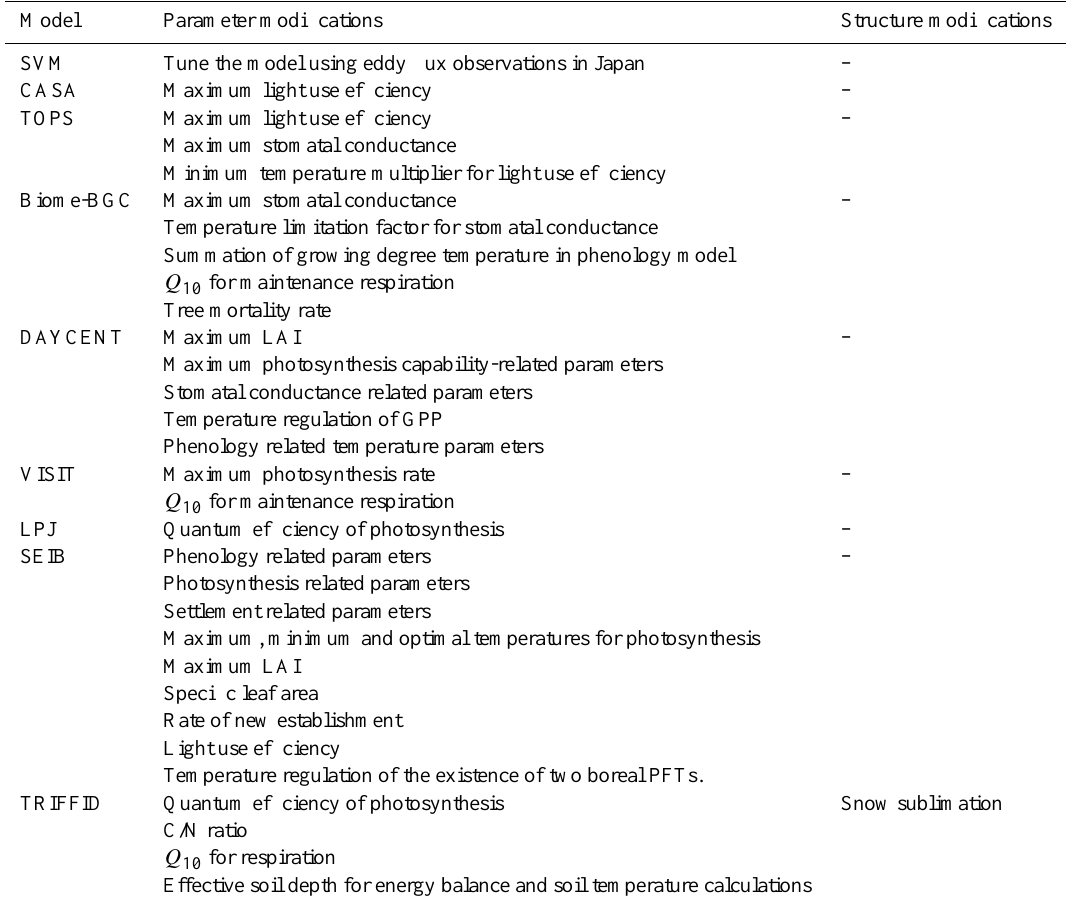
Table 3. Applied model parameter and structure modifications in this